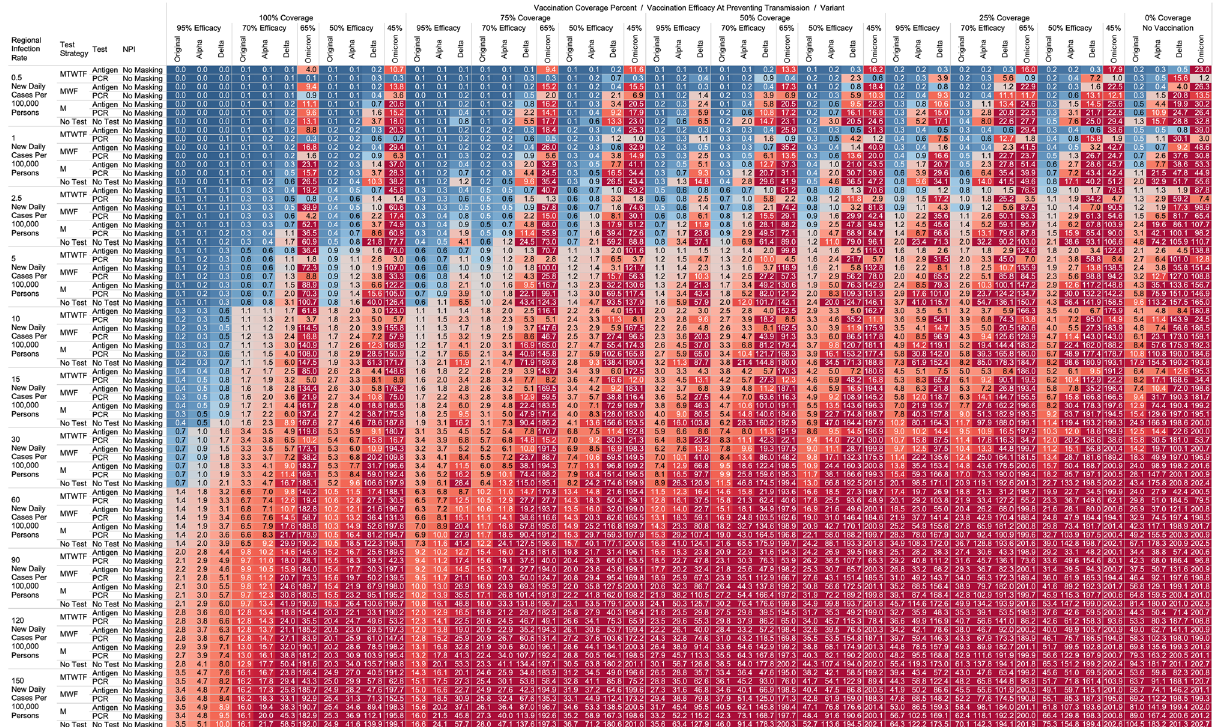
Figure 6. Heatmap of simulated total acquired infections (CAI + WAI) through 4800 person weeks with testing performed in all workplace members and with no masking intervention. The sensitivities of PCR and antigen tests a variant specific as outlined in Table